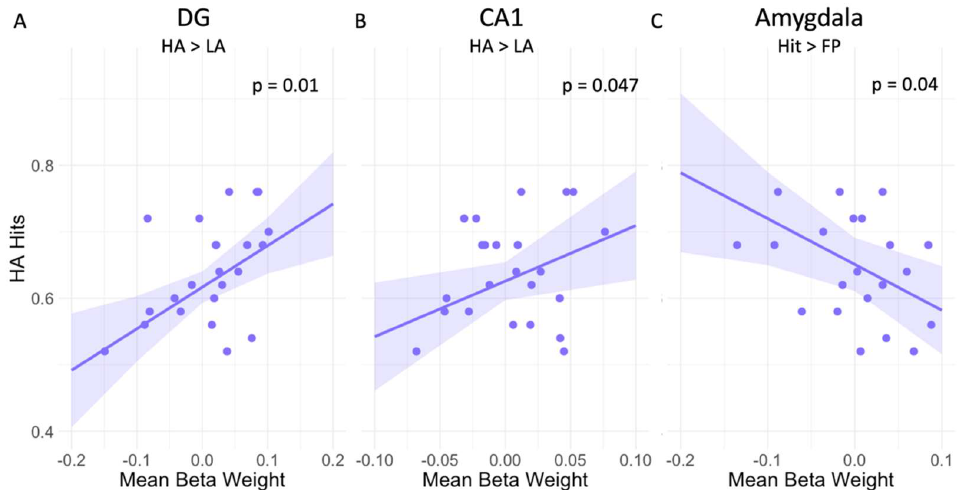
Figure 3. Association between mean ROI activity and memory performance under high arousal. Higher mean activity during high arousal compared to low arousal trials in the ( A ) DG is related to a higher proportion of hits ( B ) CA1 is related to a higher proportion of hits. ( C ) Greater deactivation in the amygdala for Hits compared to FP is associated with more high arousal Hits. Figures include the unadjusted p -values and colored bands representing the 95% CI. Abbreviations: CA = Cornu Ammonis, DG = dentate gyrus, Hit= correct answers, FP = false positives, HA = high arousal, LA = low arousal.